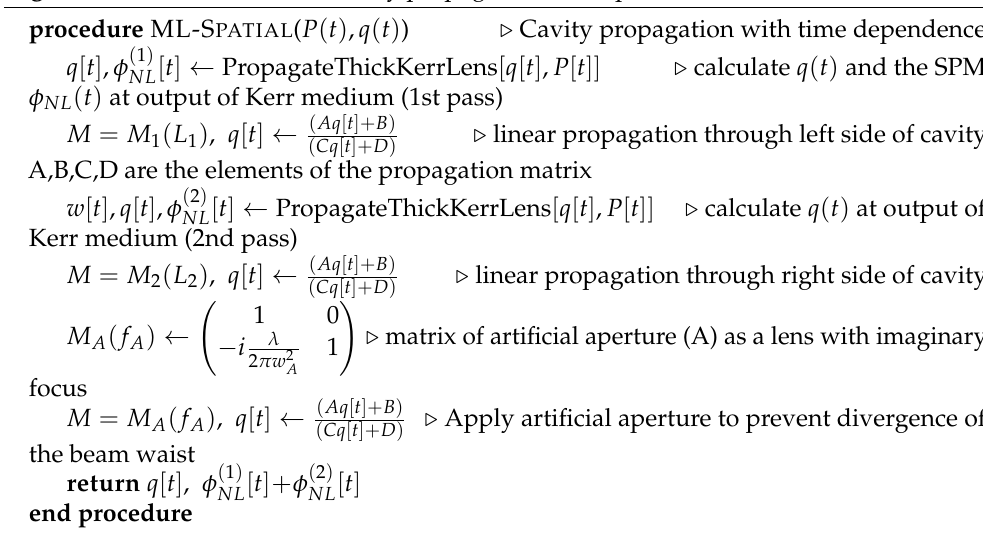
Algorithm A2 Procedures for cavity propagation with spatial